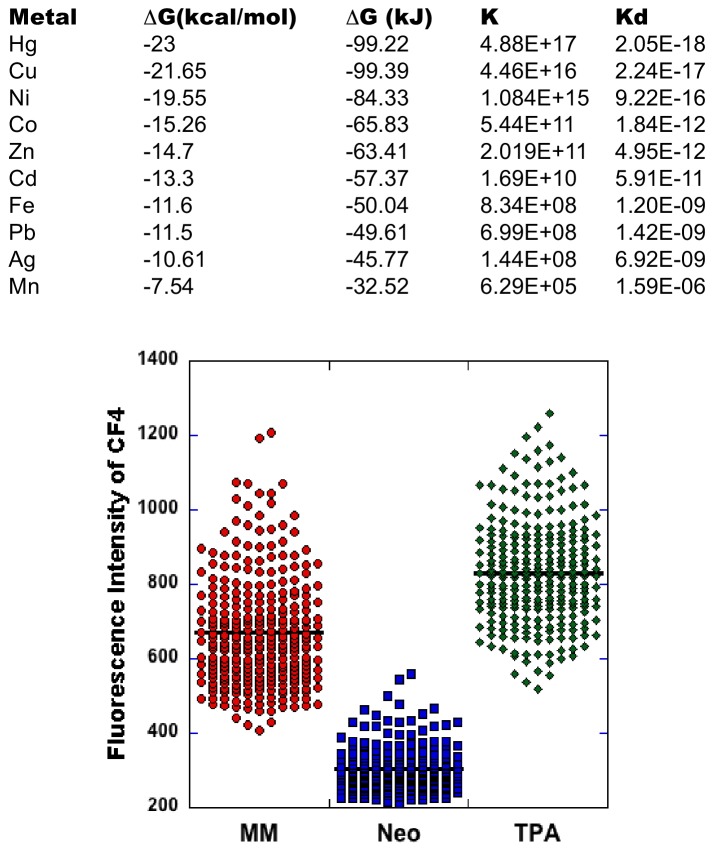
The effect of TPA on metal ions other than zinc.The ΔG values in kcal/mol for TPA binding to metals were obtained from Giorgio Anderegg et al, Helvetica Chimica Acta, Vol 60, Fasc 1 (1977) – Nr 1. These values were converted to kJ/mol and finally to a binding constant (K), assuming standard state conditions and 293K. The Kd was calculated from 1/K. Analysis of Kd values indicates that relative to other biologically relevant metal ions (Cu, Fe, Mn), TPA binds Cu more tightly than Zn. While research suggests that there is a kinetically accessible labile pool of Cu in cells (Ackerman and Chang, J. Biol. Chem., 293 (Ly et al., 2015) 4628–4635 (2017)), it has been estimated to be in the attomolar (10−18 M, Morgan et al., PNAS, 116 (Corniola et al., 2008) 1216—12172 (2019)) range and typically requires high concentrations (50–200 μM) of a high affinity chelator (bathocuproine sulfate or neocuproine, Kd = 1.2×10−20) to deplete. However, in order to test whether 3 μM TPA (the highest concentration of TPA used to induce Zn deficiency) could deplete the labile pool of Cu in cells, we used CF4 (Xiao et al., Nature Chem. Bio. (Matson and Cook, 2017) 655–663 (2018)). Cells in minimal medium were treated with 50 μM neocuproine for 30 min or 3 μM TPA for 20 hr. At the end of treatment, 2 μM CF4 (dissolved in methanol) was added for 20 min. After washing cells 3x, cells were imaged on a spinning disc confocal with 514 nm excitation. The plot above shows the background corrected fluorescence intensity for individual cells (286 cells for MM, 231 cells for neo and 266 for TPA). Neocuproine depletes the labile Cu pool (p<0.0001, ANOVA with Tukey HSD post-hoc test) but TPA does not.